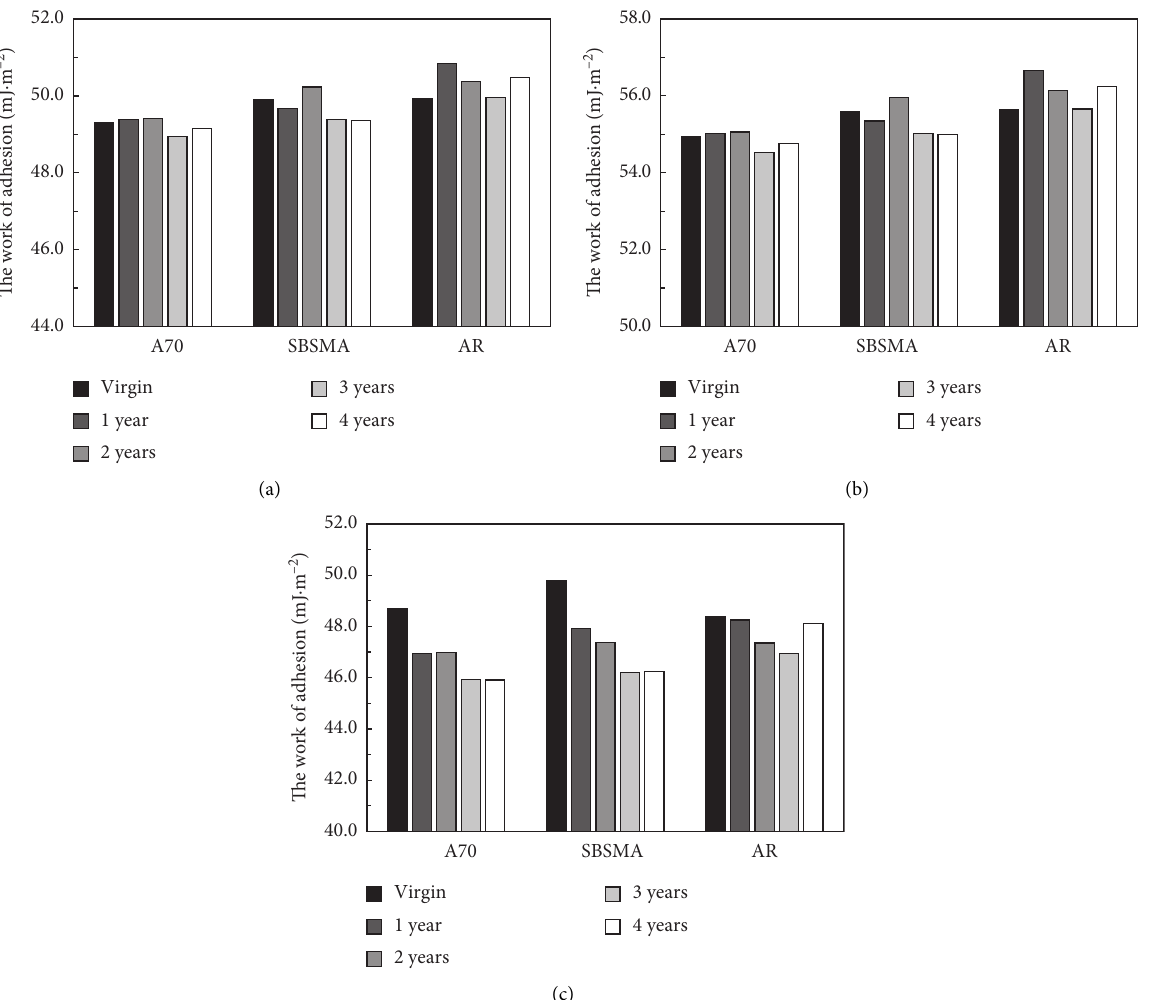
Figure 7: Work of adhesion between asphalt and (a) limestone, (b) basalt, and (c) granite under dry conditions.